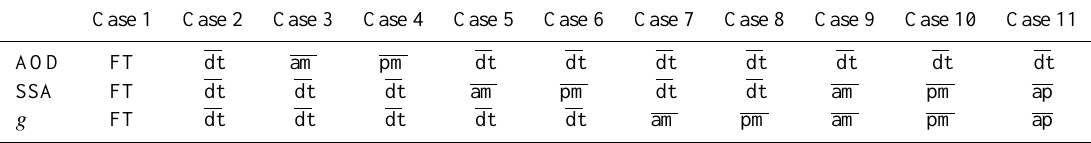
Table 1. Designed cases.